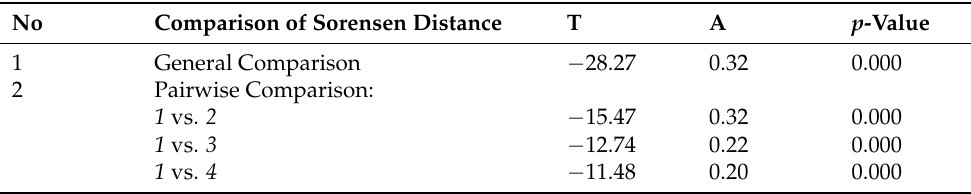
Table A2. Summary statistics of multi-response permutation procedure (MRPP) analysis for tree vegetation